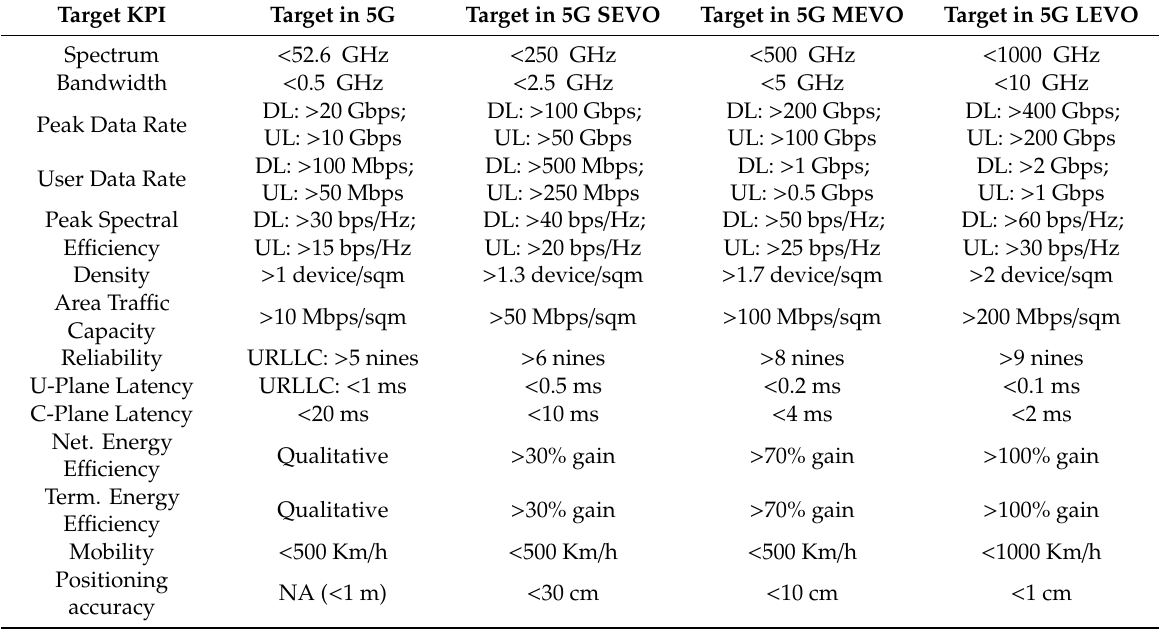
Figure 1. Evolution of targeted KPIs for the shot, medium, and long-term evolution of 5G new radio (NR). Table 2. Targeted KPIs for the short, medium, and long-term evolution of 5G NR.